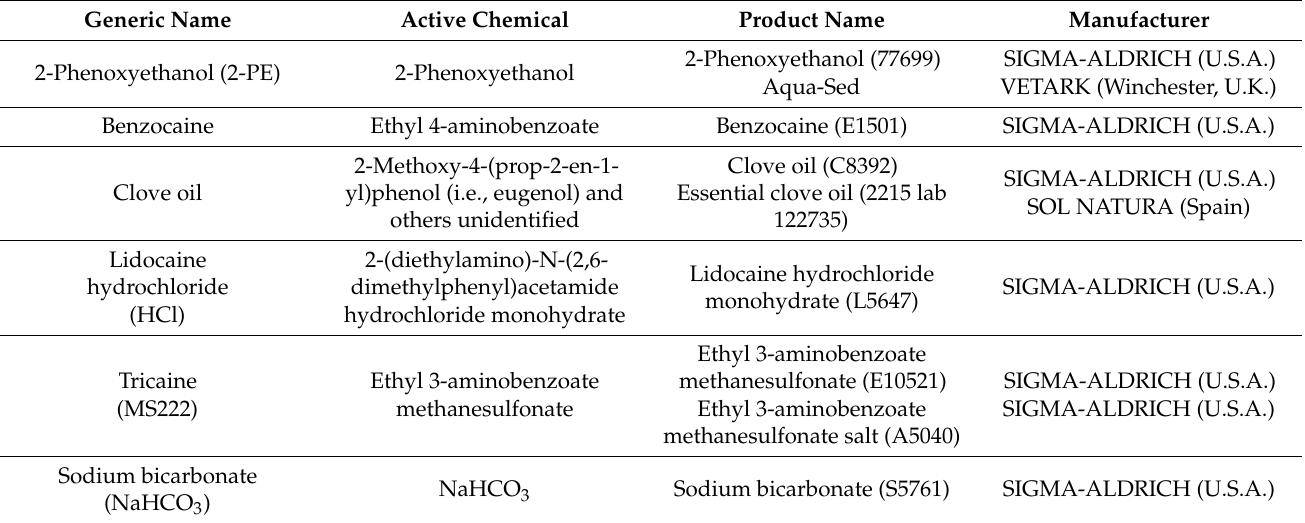
Table 2. Overview of experimental anesthetics and buffer. Sigma-Aldrich (Saint-Louis, MO, USA).